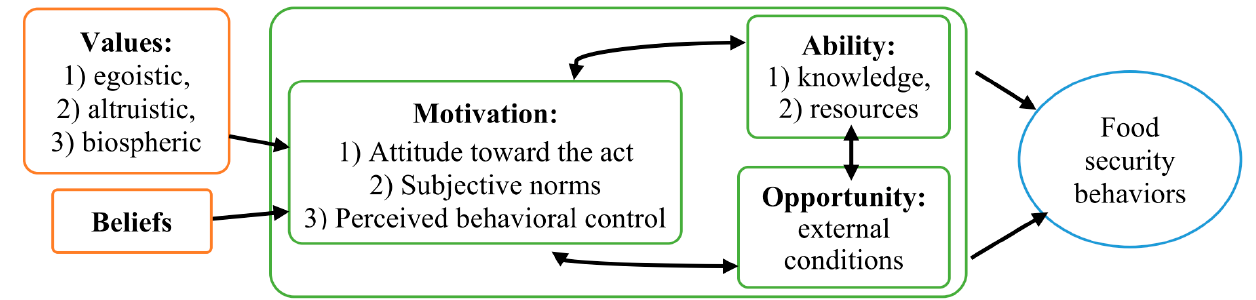
Figure 1. Integrated models of food security behaviors (adapted from Thøgersen [11]; Ajzen [12]; Ajzen [13]; Stern [14]).